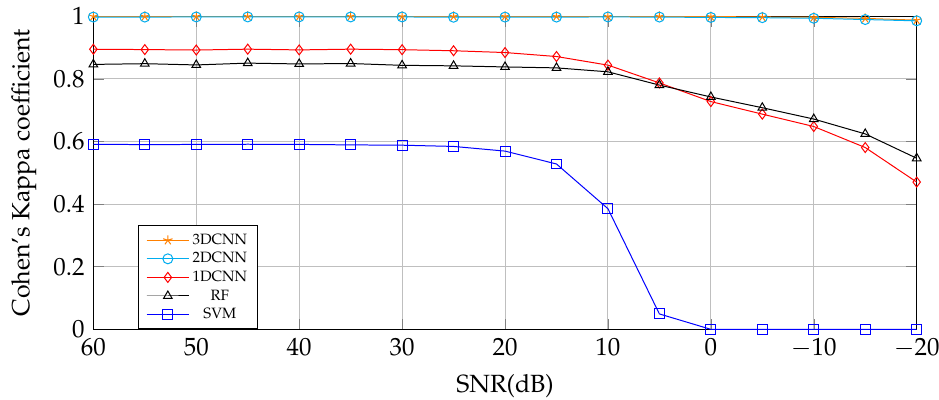
Figure 12. University of Pavia. Cohen’s Kappa coefficient obtained by different classifiers for UP HSI compressed with TKD to 40 tensorial bands training with 10% of TS. The best performance is achieved by 3DCNN and 2DCNN, then 1DCNN, RF, and SVM in descending order.